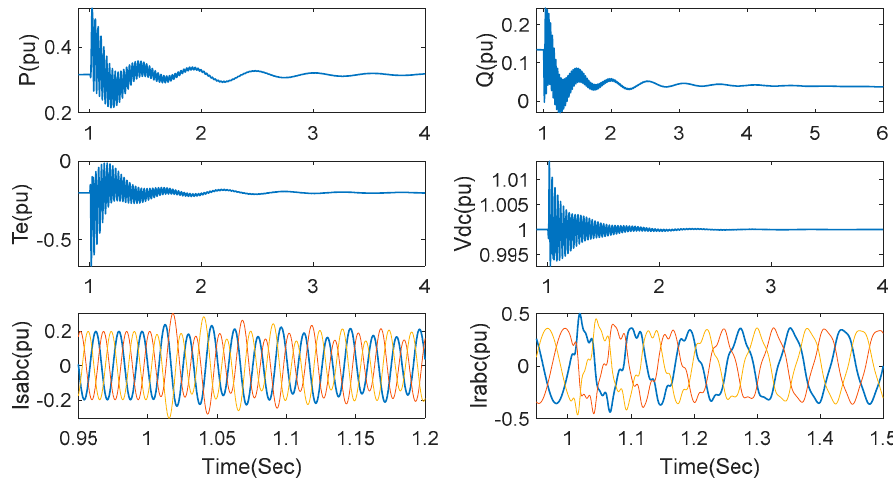
Figure 8. Responses under the proposed method with series compensation 75% and wind speed 7 m/s.